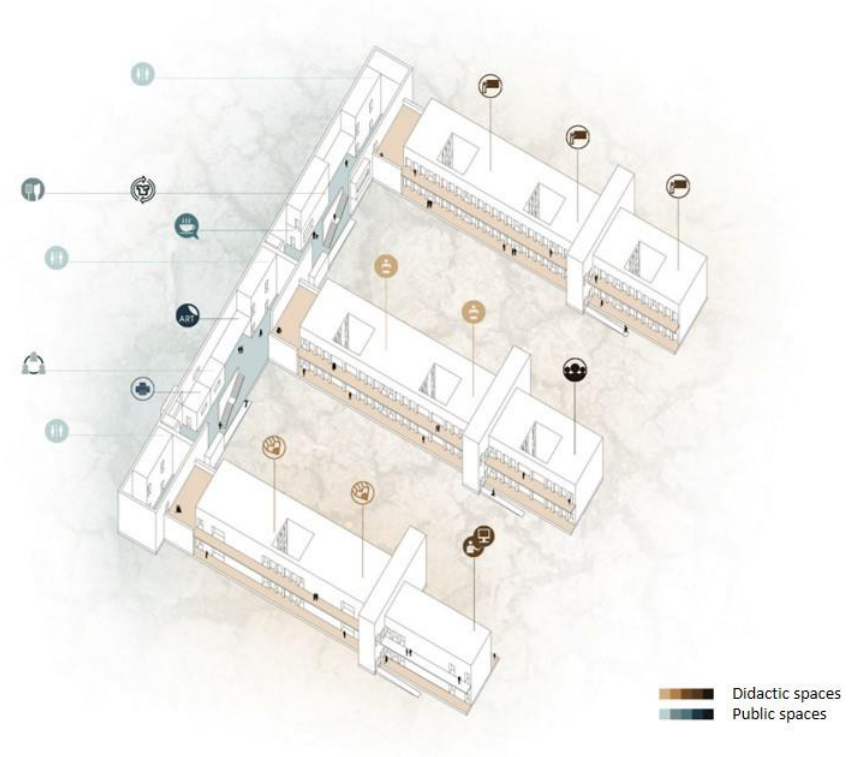
Figure 6. Typical internal distribution of modular block in 2019 proposal.